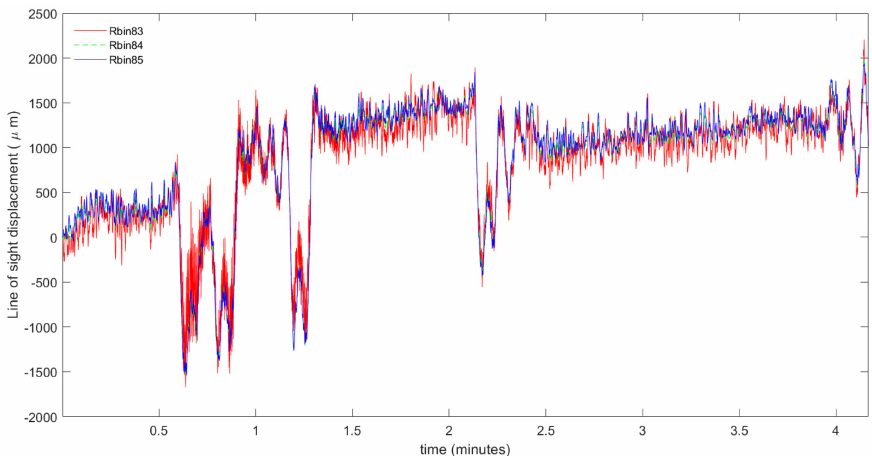
Figure 10. Line-of-sight (LOS) displacement time histories in the middle of 192-m span monitored by IBIS-S.